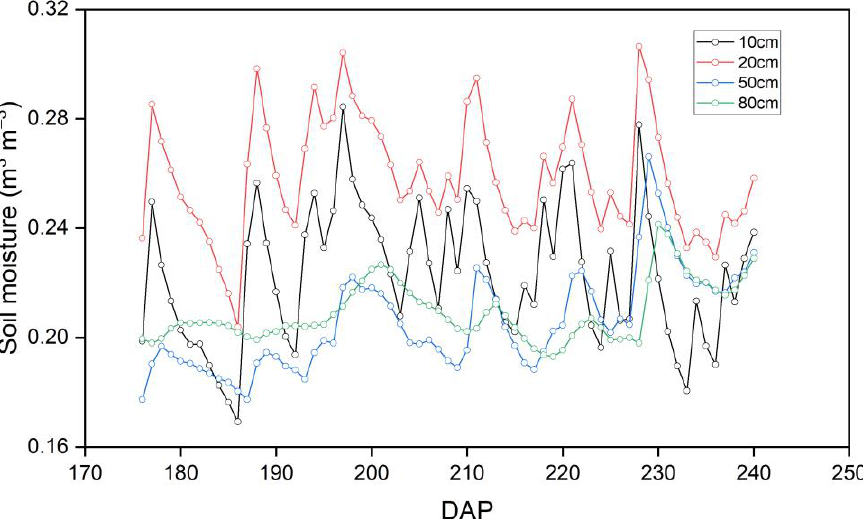
Figure 8. Seasonal variation of soil moisture at different depths in T1. DAP means days after